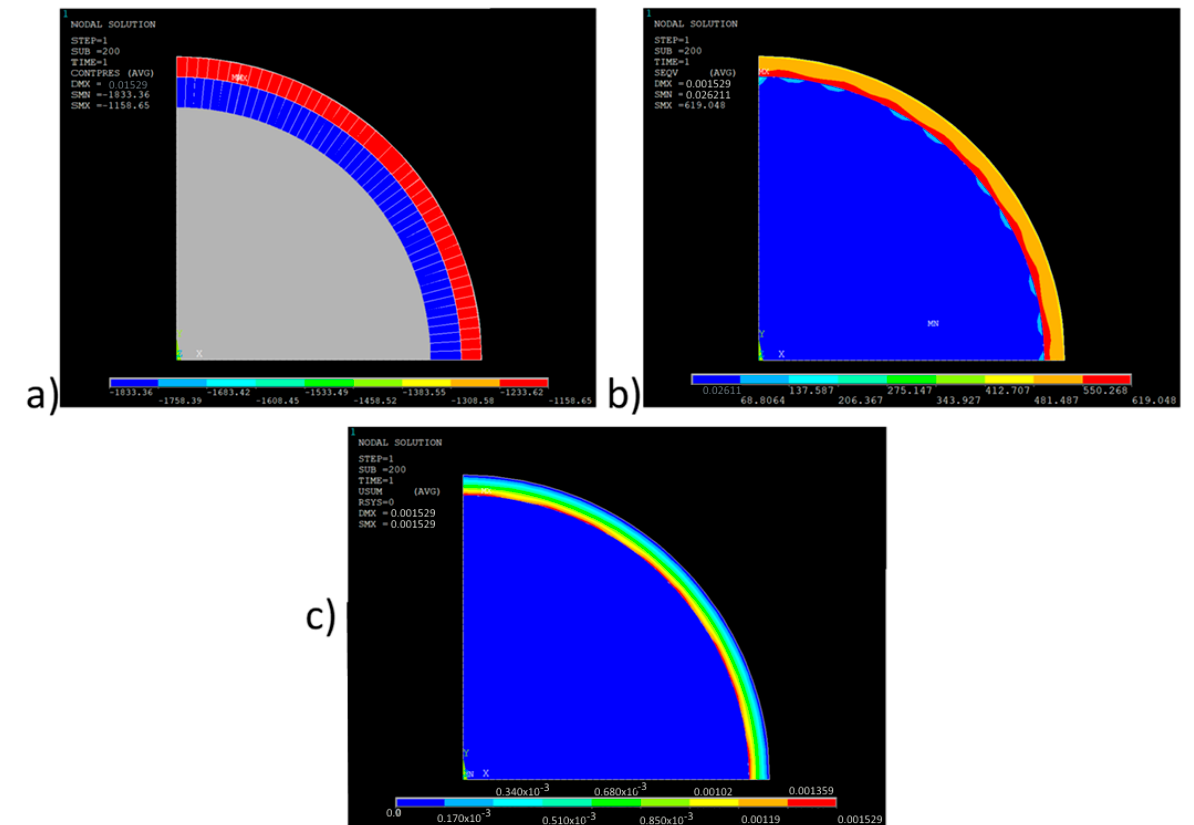
Figure 22. ( a ) Distribution of contact pressure p inter between the ball joint pin and its bearing; ( b ) Corresponding Mises stresses; ( c ) Corresponding displacements.